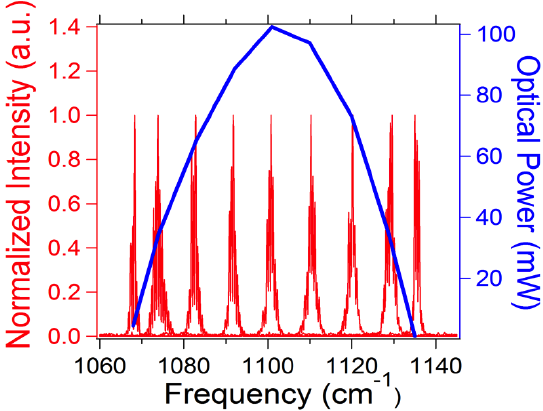
Figure 4. Tuning curve of the CW AOM-controlled laser under the same laser driving conditions as the ones listed in Figure 3.